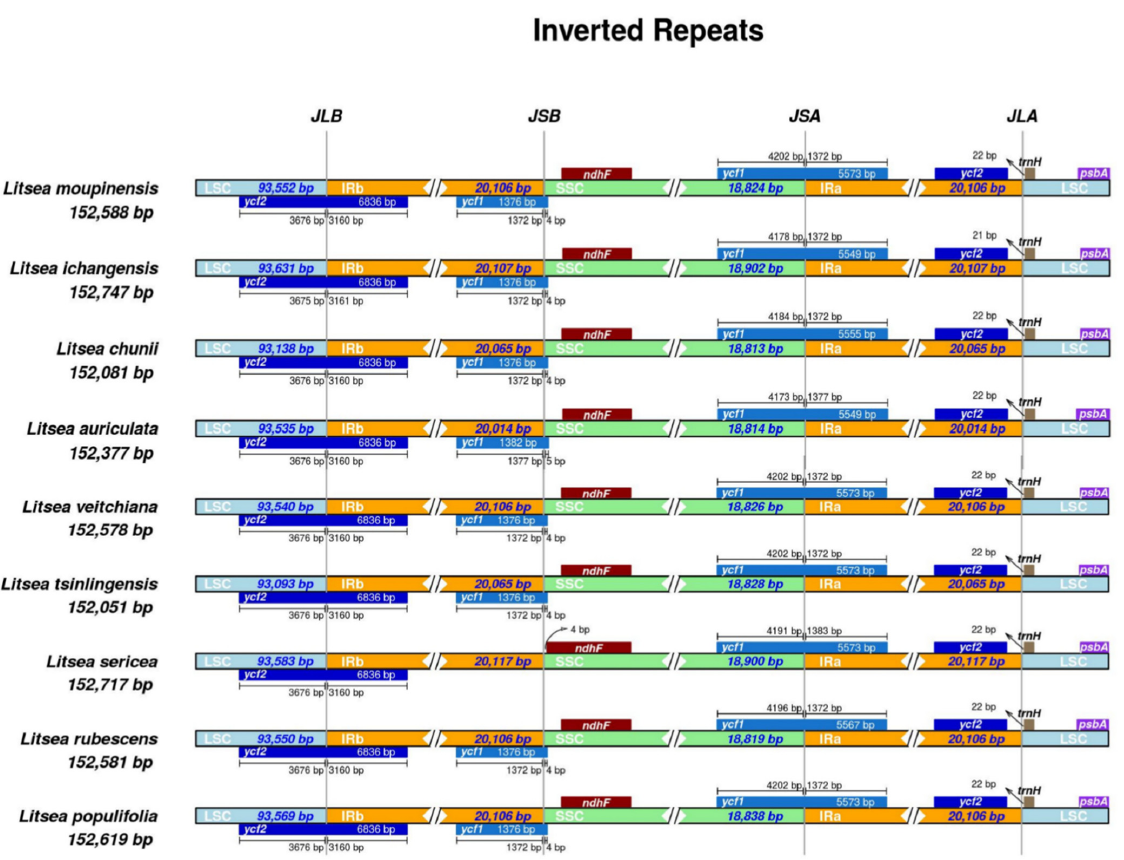
Figure 4. Comparison of SSC, LSC, IRa, and IRb boundary regions in the chloroplast genomes of nine species of Litsea .